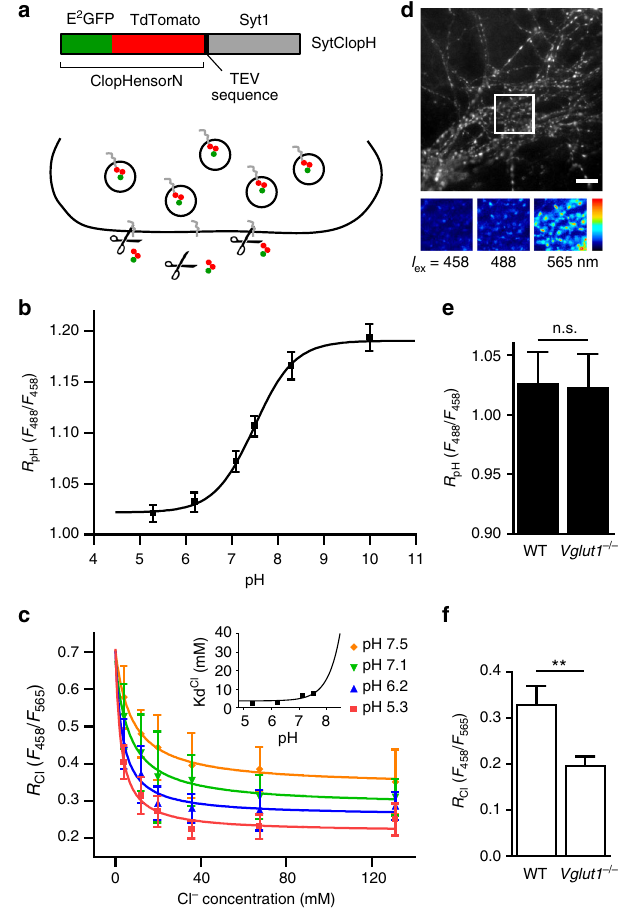
Fig. 4 Absence of VGLUT1 prevents the ef fl ux of luminal Cl − . a The synaptotagmin 1-ClopHensorN (SytClopH) construct is composed of the previously described ClopHensorN (E 2 GFP-TdTomato fusion) 37 fused to the cleavage site for recombinant TEV protease and synaptotagmin 1 (Syt1) (top). When neurons-overexpressing SytClopH were exposed to 60 U ml – 1 TEV protease (scissors) at room temperature, ClopHensorN was cleaved from molecules residing in the plasma membrane while vesicular SytClopH was inaccessible to the protease (bottom). b SytClopH calibration curve relating pH to the ratio of fl uorescence emission when E 2 GFP was excited at 488 nm over the emission when excited at 458 nm ( R pH ). p K a was found to be 7.49 with a fi tted 95% con fi dence interval between 7.23 and 7.76. Note that variation of Cl − concentration within the physiological range had no effect on RpH (Supplementary Fig. 7). c SytClopH calibration curve relating Cl − concentration to the ratio of fl uorescence emission when E 2 GFP was excited at 458 nm over the emission when TdTomato was excited at 565 nm ( R Cl ). Change in pH in fl uences the af fi nity of SytClopH for Cl − . d Fluorescence image of hippocampal axonal arborisations of wild-type neurons expressing SytClopH collected following excitation at 565 nm. The insets (bottom) show a higher magni fi cation with excitation at 458, 488 and 565 nm respectively. Scale bar represents 10 µ m. e , f Histogram of the measured R pH ( e ) and R Cl ( f ) in hippocampal neurons from wild-type (WT, n = 29) and VGLUT1 knock-out ( Vglut1 − / − , n = 27) mice. n.s. not signi fi cant P = 0.9447; ** P = 0.0060 analysed with two-tailed unpaired t -test. Error bars represent